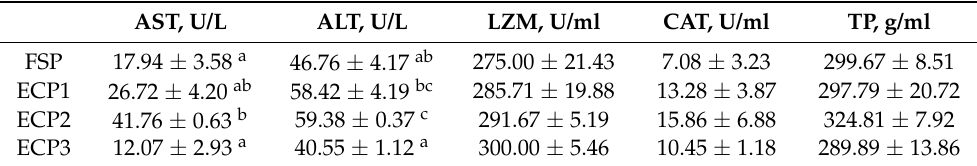
Table 6. Effect of fish soluble pulp and enzymatic chicken pulp in the serum enzyme activities of L. vannamei .